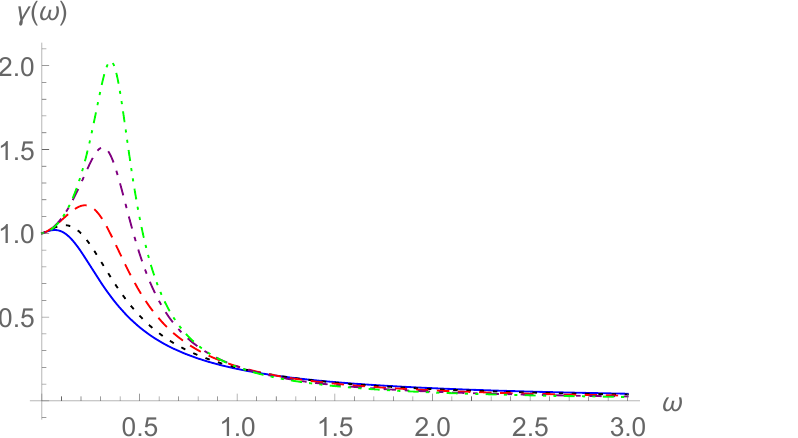
Figure 12. Frequency–amplitude curves γ ( ω ) for k = m = 1, c = 0.5, η = 5, and p = 0.01 (solid line), p = 0.1 (dotted line), p = 1 (dashed line), p = 10 (dot-dashed line), or p = 100 (dot-dot-dashed line).